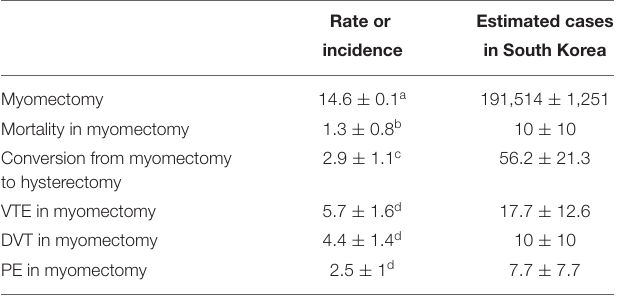
TABLE 4 | The rates or estimated cases about myomectomy in HIRA-NIS 2009-2018.